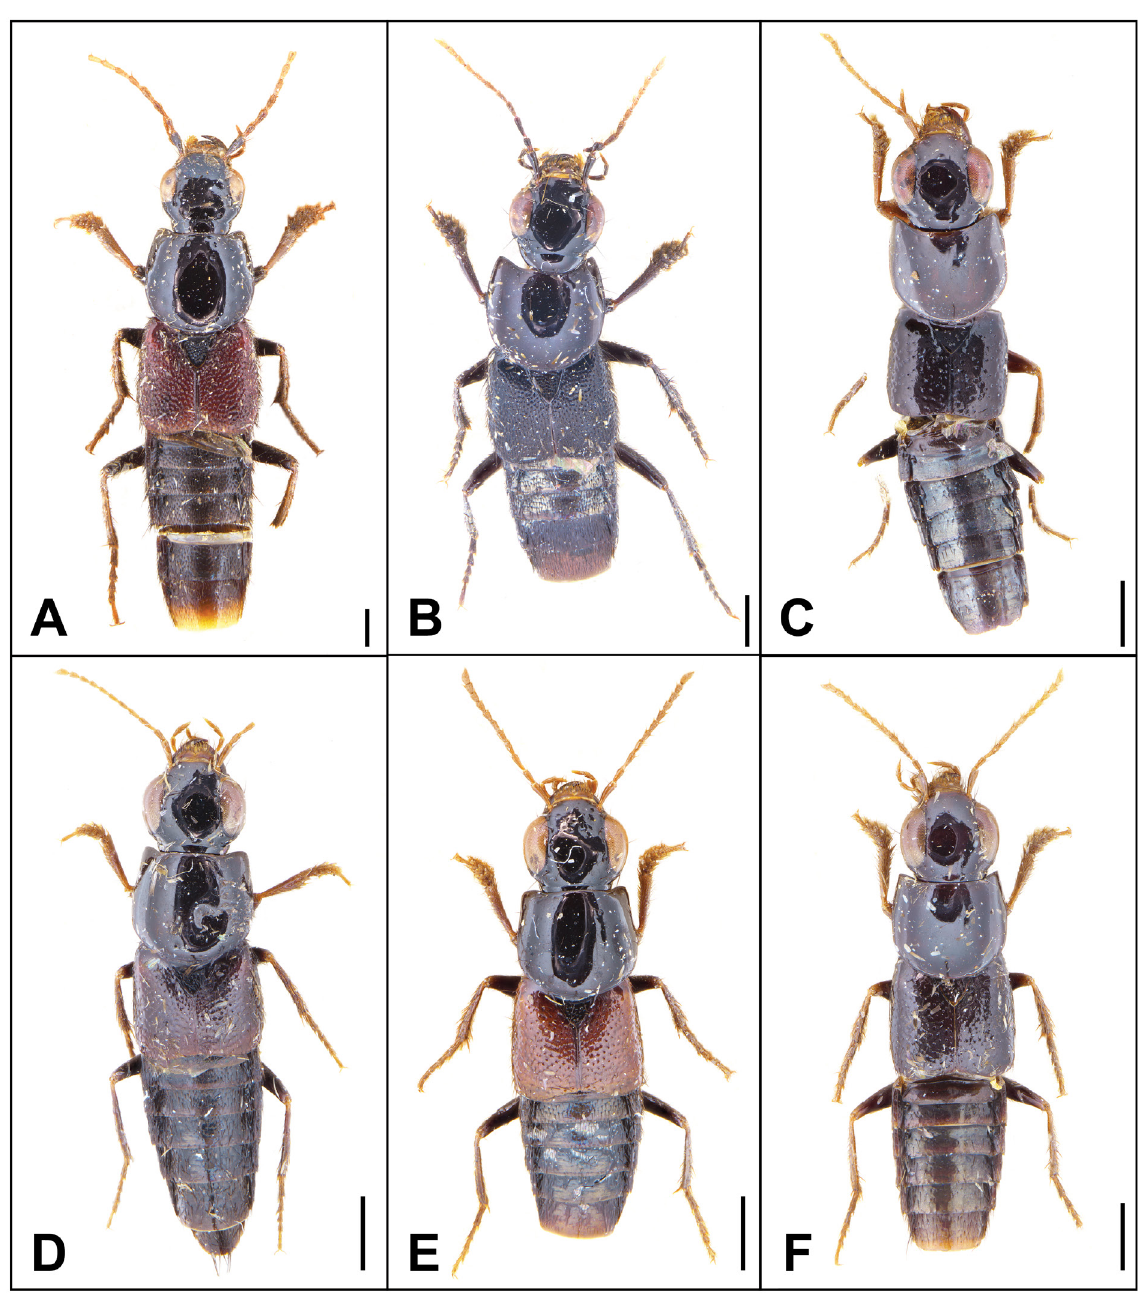
Fig. 1. Habitus of Indoquedius described by Scheerpeltz (1965). A . I. malaisei , ♂, holotype (NHRS). B . I. micantiventris , ♂, holotype (NHRS). C . I. dispersepunctatus , ♀, holotype (NHRS). D . I. parallelicollis , ♀, paratype (NHW). E . I. sanguinipennis syn. nov. (= I. parallelicollis ), ♀, holotype (NHRS). F . I. recticollis , ♀, holotype (NHRS). Scale bars = 1